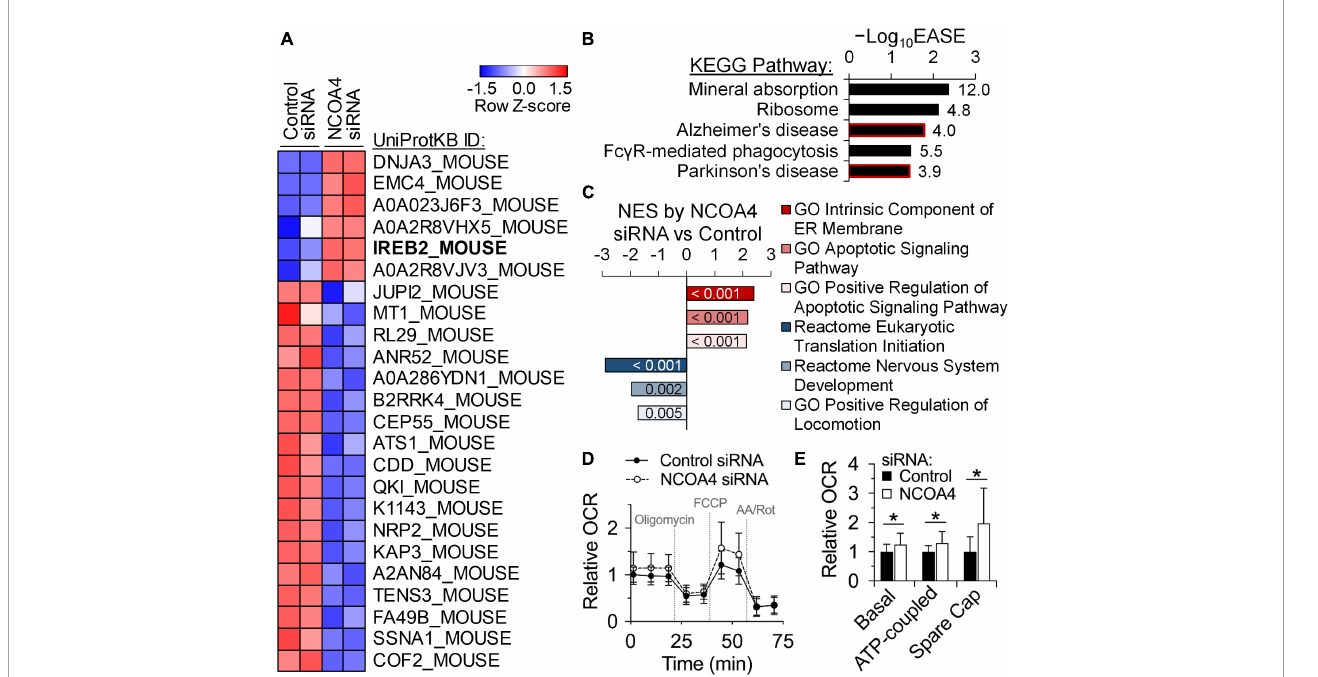
FIGURE3 Quantitative proteomics identify roles of NCOA4 in apoptosis, translation, and neuronal functioning and development. Protein expression profiles of control and NCOA4-depleted HT22 cells were compared using the tandem mass tag quantitative proteomics approach. (A) Expression of proteins with FC values above 2.0 or below -2.0, and P < 0.05. Heatmap was generated with Z-scores of Log 2 -transformed normalized expression values. (B) KEGG Pathways enriched by DE proteins of NCOA4-depleted cells with |FC| > 1.5 and P < 0.05, which were identified using the DAVID functional annotation analysis. EASE Score is a modified Fisher’s exact P -value from the DAVID tool. Numbers next to each bar indicate fold enrichment for DE proteins. (C) Normalized enrichment scores (NES) of gene sets significantly enriched by proteins DE by NCOA4 depletion ( P < 0.05) from GSEA. Numbers in each bar indicate P -value of enrichment by the DE proteins. (D) Effects of NCOA4 depletion on real-time OCRs after treatments of oligomycin, FCCP, and antimycin A/rotenone. Individual well OCR values were normalized to cell density. Data from n = 3 independent cultures and are presented as mean ± SD. (E) Basal respiration, ATP-coupled respiration, and spare respiratory capacity (Spare Cap) calculated from OCR measurements (D) . * P < 0.05 compared with control levels. FC, fold-change; KEGG, Kyoto Encyclopedia of Genes and Genomes; DE, differentially expressed; DAVID, Database for Annotation, Visualization, and Integrated Discovery; GSEA, Gene Set Enrichment Analysis; OCR, oxygen consumption